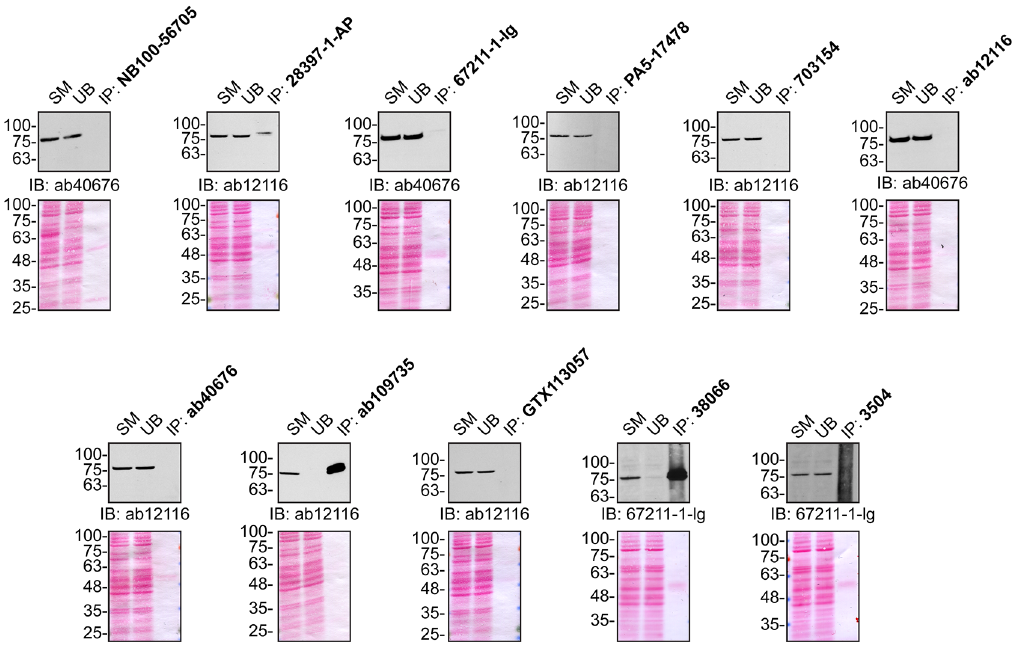
Figure2.Serine/thronine-protein kinaseTBK1screeningbyimmunoprecipitation. U2OSlysateswereprepared and IP was performed using 1.0 μ g of the indicated TBK1 antibodies pre-coupled to either protein G or protein